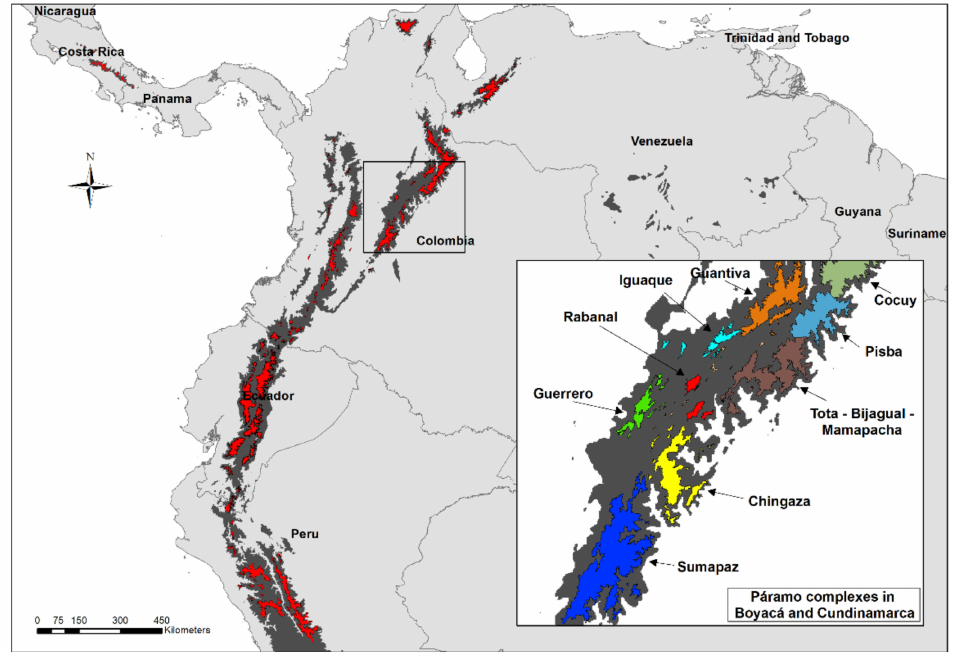
Figure 1. Present-day area covered by p á ramos (red) and high Andean forests (dark gray). Magnified box shows the p á ramo complexes within the Boyac á and Cundinamarca massifs labeled in different colors. Map created in the software ArcGIS